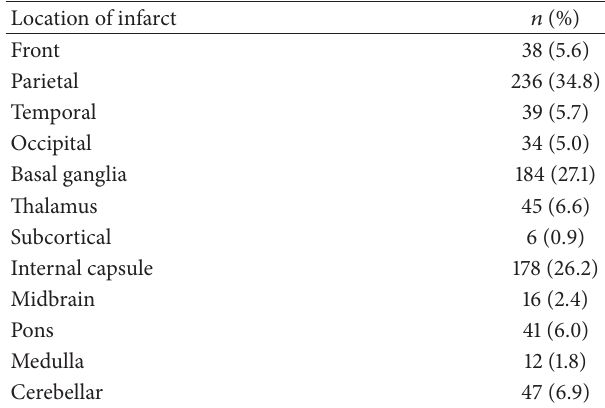
Table 1: Known risk factors ( 𝑛 = 679 ). Table 2: Infarct location ( 𝑛 = 679